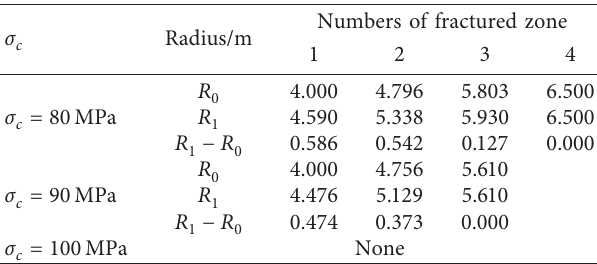
Figure 4: Distribution of self-sustaining time-varying structures of the surrounding Table 1: The width and quantity of fractured zone when excavation time is 1s [35].